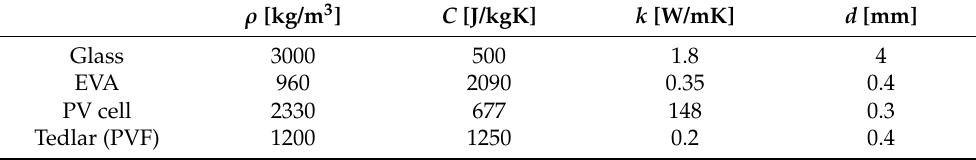
Table 3. Thermal and mechanical parameters of the considered mono-crystalline PV module. ρ [kg/m 3 ] C [J/kgK] k [W/mK] d [mm] Glass 3000 500 1.8 4 EVA 960 2090 0.35 0.4 PV cell 2330 677 148 0.3 Tedlar (PVF) 1200 1250 0.2